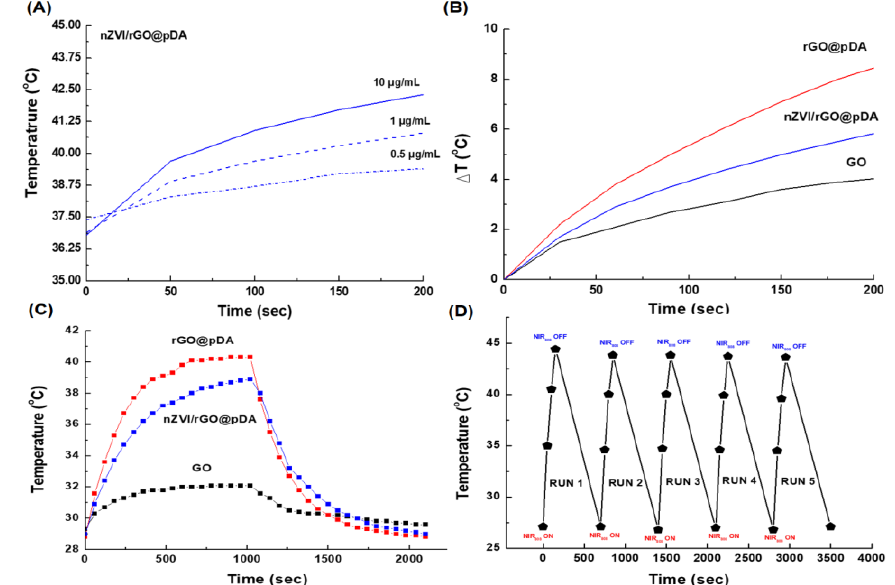
Figure 4. Photothermal e ff ects of nano zero-valent iron immobilized on the surface of reduced graphene oxide compared to modified with dopamine. ( A ) Photothermal heating of di ff erent concentrations of nZVI / rGO@pDA (0.5–10 µ g / mL) during NIR irradiation (880 nm, 1.5 W / cm 2 ). ( B ) Photothermal heating of GO, rGO@pDA, and nZVI / rGO@pDA (10 µ g / mL) during NIR irradiation (880 nm, 1.5 W / cm 2 ). ( C ) Photothermal conversion e ffi ciency of GO, rGO@pDA, and nZVI / rGO@pDA under NIR illumination. ( D ) Photothermal stability of nZVI / rGO@pDA under NIR illumination. All experiments were performed three times independently. Abbreviations: GO, graphene oxide; nZVI / GO, reduced graphene oxide modified with dopamine; nZVI / rGO@pDA, nano zero-valent iron immobilized on the surface of reduced graphene oxide then modified with dopamine.